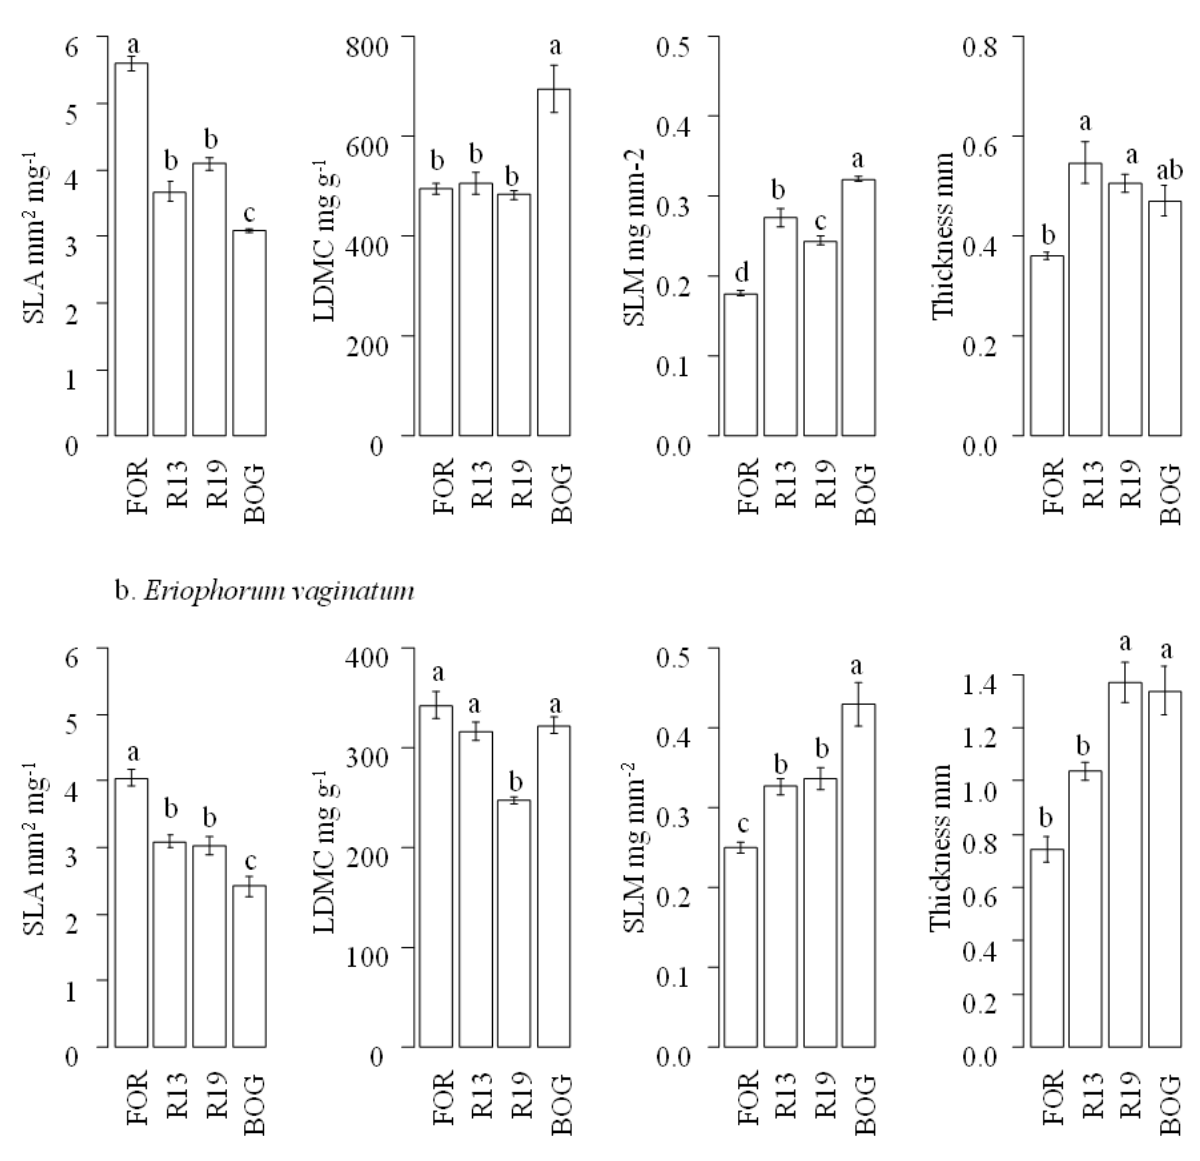
Figure 2. Mean and standard error values for destructive morphological traits measured for a) Erica tetralix (5 replicates, 200 leaves per replicate) and b) Eriophorum vaginatum (10 replicates, 1 leaf per replicate). SLA = Specific Leaf Area, LDMC = Leaf Dry Matter Content, SLM = Specific Leaf Mass; FOR = forested control, R13 = forest-to-bog restoration site aged 13 years, R19 = forest-to-bog site aged 19 years BOG = natural open blanket bog control. The letters above the bars indicate significant difference, i.e. for a given plant and trait; where the letters differ there was a significant effect of site (p <